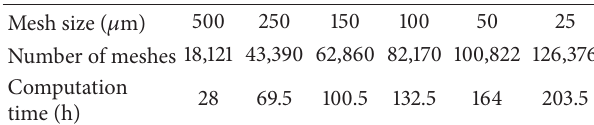
Table 6: Number of meshes and computational time for six sorts of mesh sizes using tetrahedron